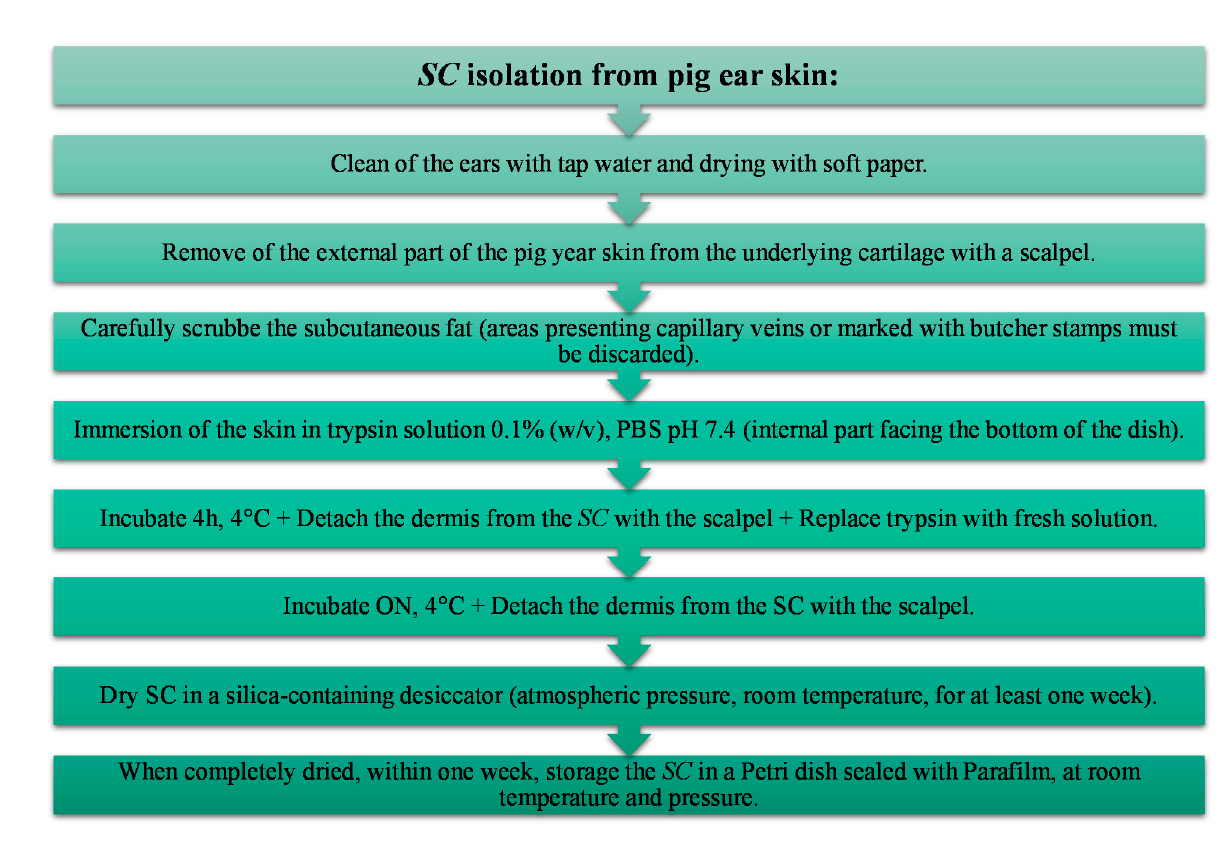
Figure 6. Flow chart of the protocol defined for SC isolation from pig ear skin by trypsin digestion.